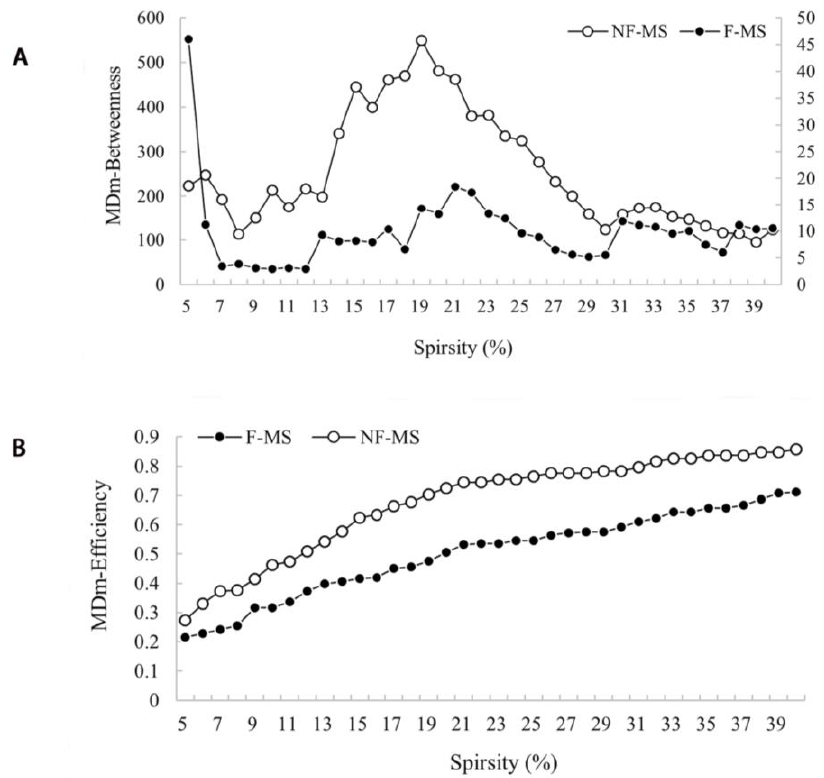
Figure 3. Nodal betweenness centrality ( A ) and nodal efficiency ( B ) for a range of sparsity in the F-MS (●) and NF -MS ( ○ ) groups. Data were analyzed by comparing the AUCs among the parameters for each group. The FDR was used to correct for multiple comparison. Relative to NF-MS group, F-MS group exhibited reduced nodal betweenness centrality ( A ) and nodal efficiency ( B ) in the right mediodorsal medial magnocellular nuclei (all with FDR corrected p < 0.05). F-MS: Patients with multiple sclerosis presenting fatigue; NF-MS: Patients with multiple sclerosis not presenting fatigue; HCs: Healthy controls.